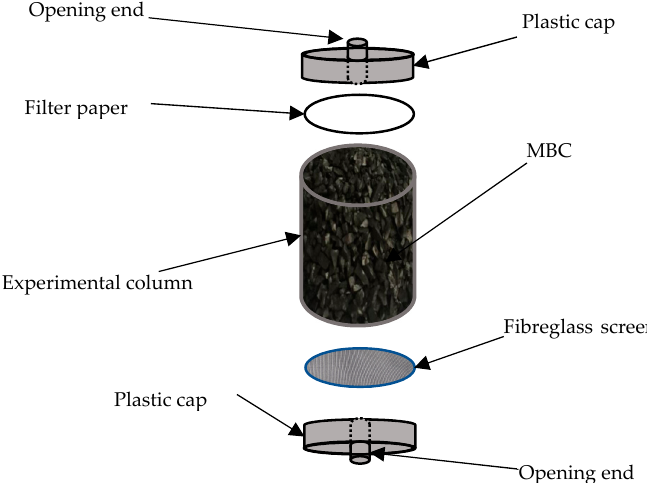
Figure 1. Schematic diagram of macadamia nutshell (MBC) column design.